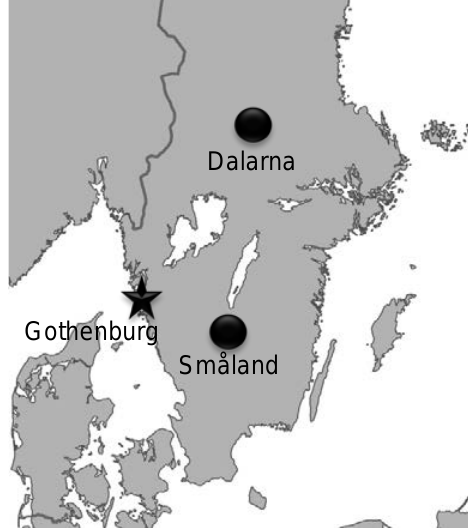
Figure 5. The plant and sourcing